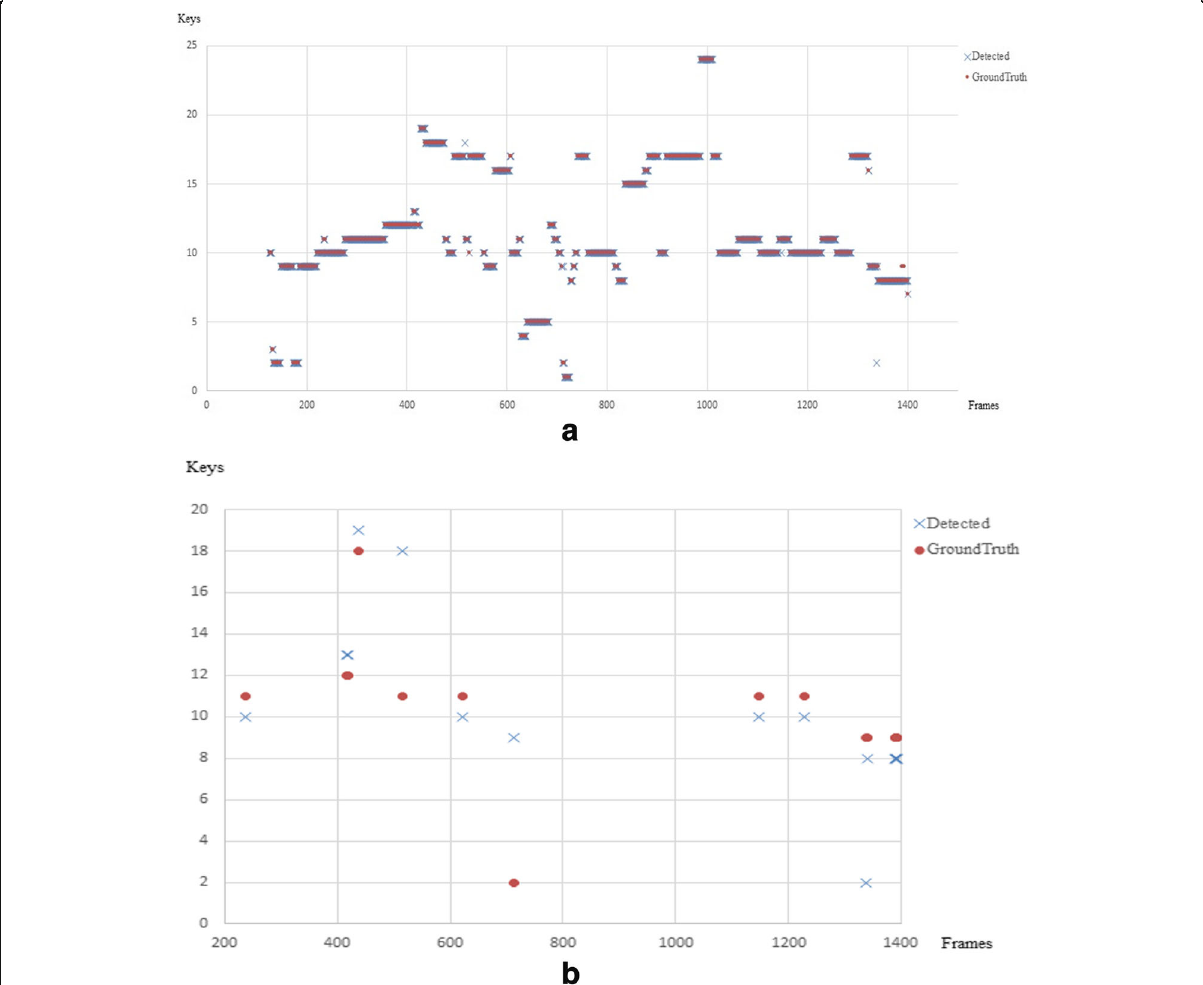
Fig. 9 Performance of hand segmentation in virtual keyboard interaction. a Fingertip detection results compared with ground truth. b Close-up of errors in